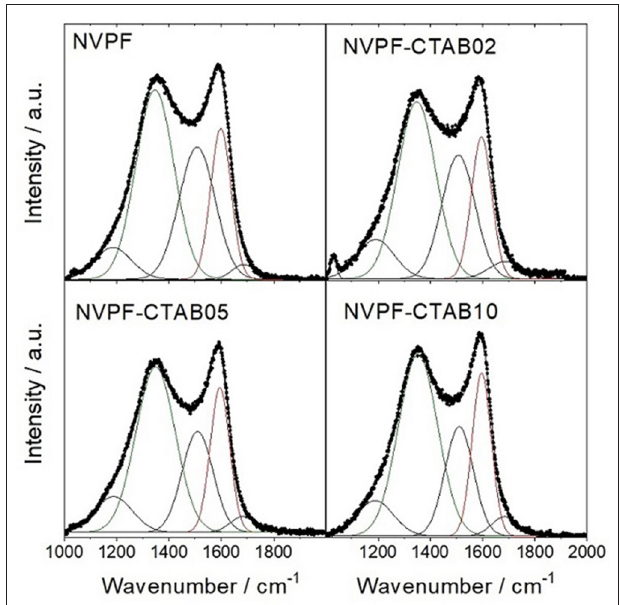
0 = 532nm. The band assignment has been